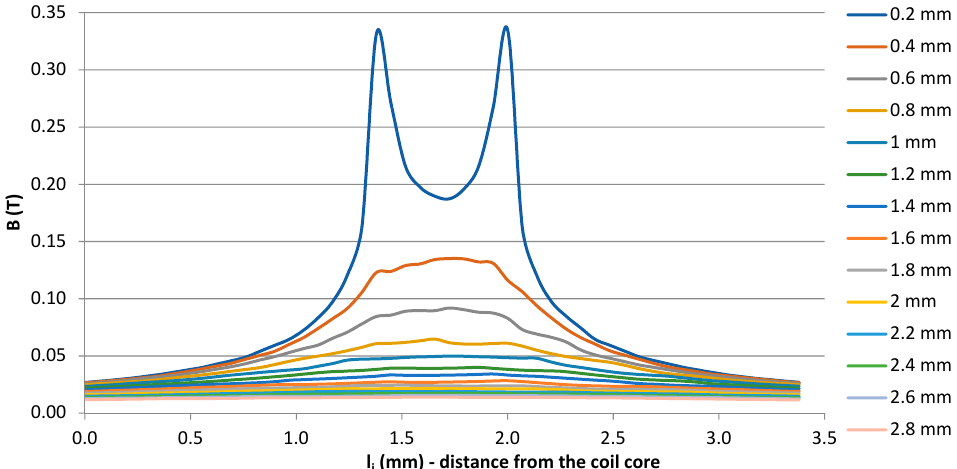
Figure 15. Magnetic induction distribution along with one of the distributed air gaps of the inductor described by situation Figure 12b.